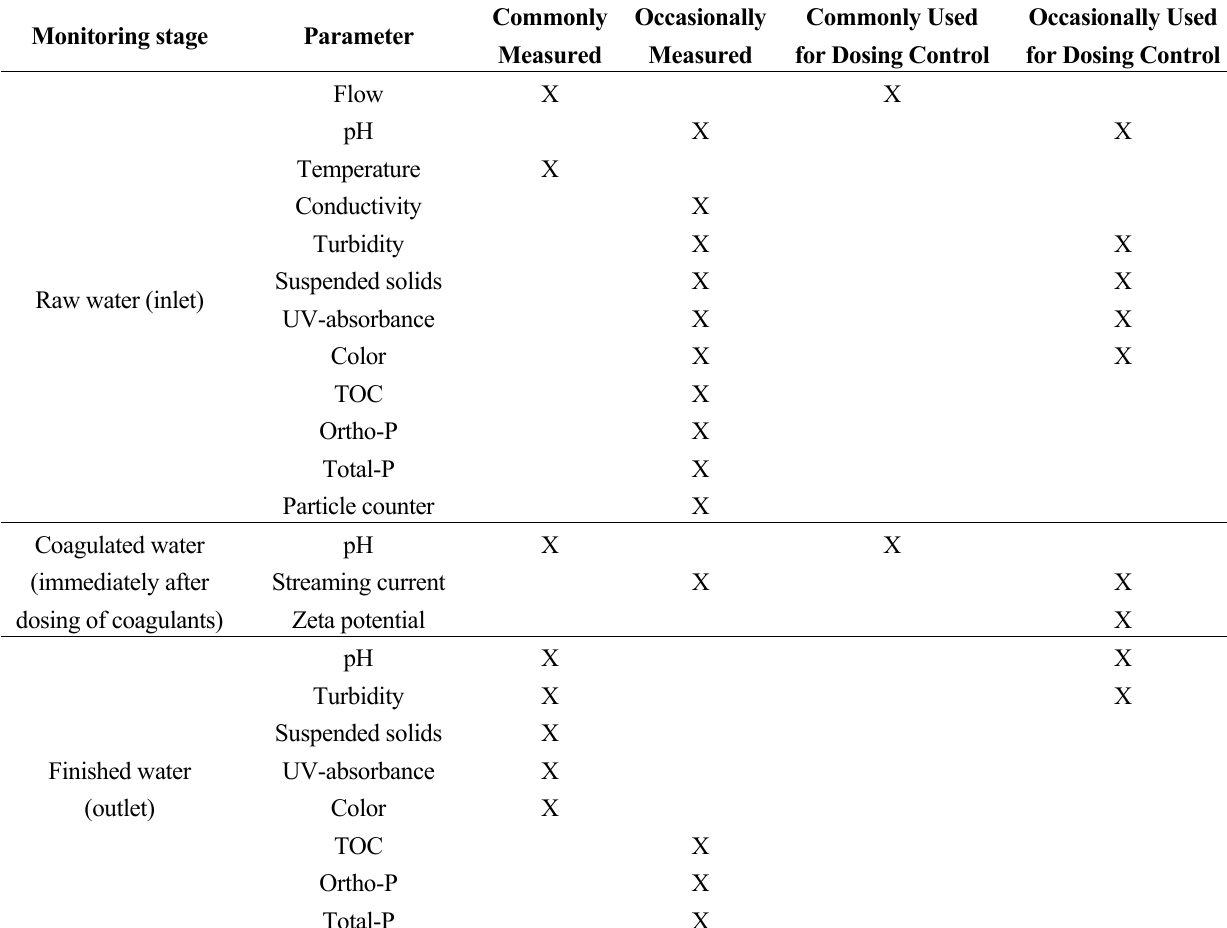
Table 1. Online sensors applied for monitoring and control of the coagulation process, according to experiences and applications in Northern Europe/Scandinavia. Commonly Occasionally Commonly Used Occasionally Used Parameter Measured Measured for Dosing Control for Dosing